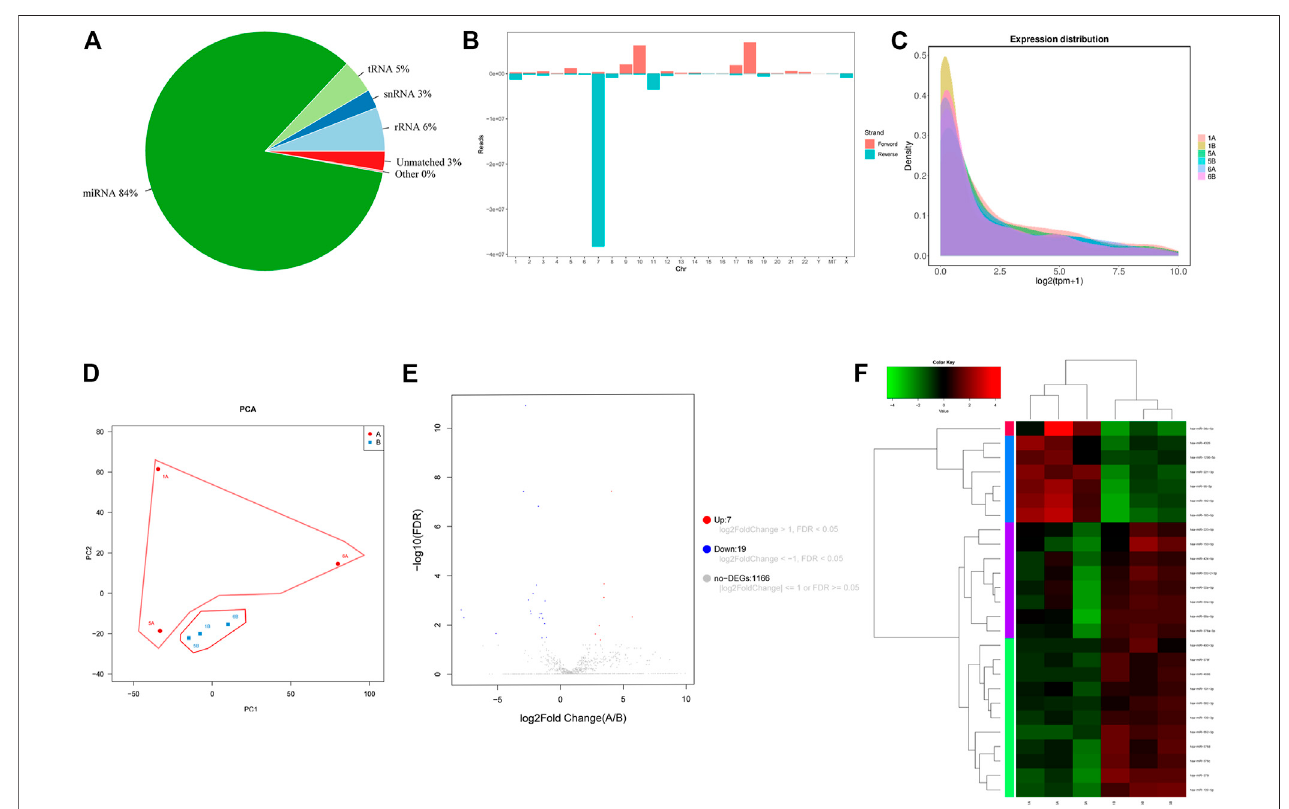
FIGURE 1 | (A) 2D pie diagram of the number/total amount of common and unique sequences between samples. (B) The clean reads of all samples and the referencegenomecomparisonresultsaredisplayed. (C) Distribution oftheexpression densityofallsamples. (D) PCAdiagramofsampleexpression. (E) Volcano plotof the differential expression pro fi les of miRNAs. The blue dots represent downregulated miRNAs, and red dots represent upregulated miRNAs. (F) Heatmap of the differential expression pro fi les of miRNAs. “ A ” : hepatocellular carcinoma. “ B ” : adjacent tissue.